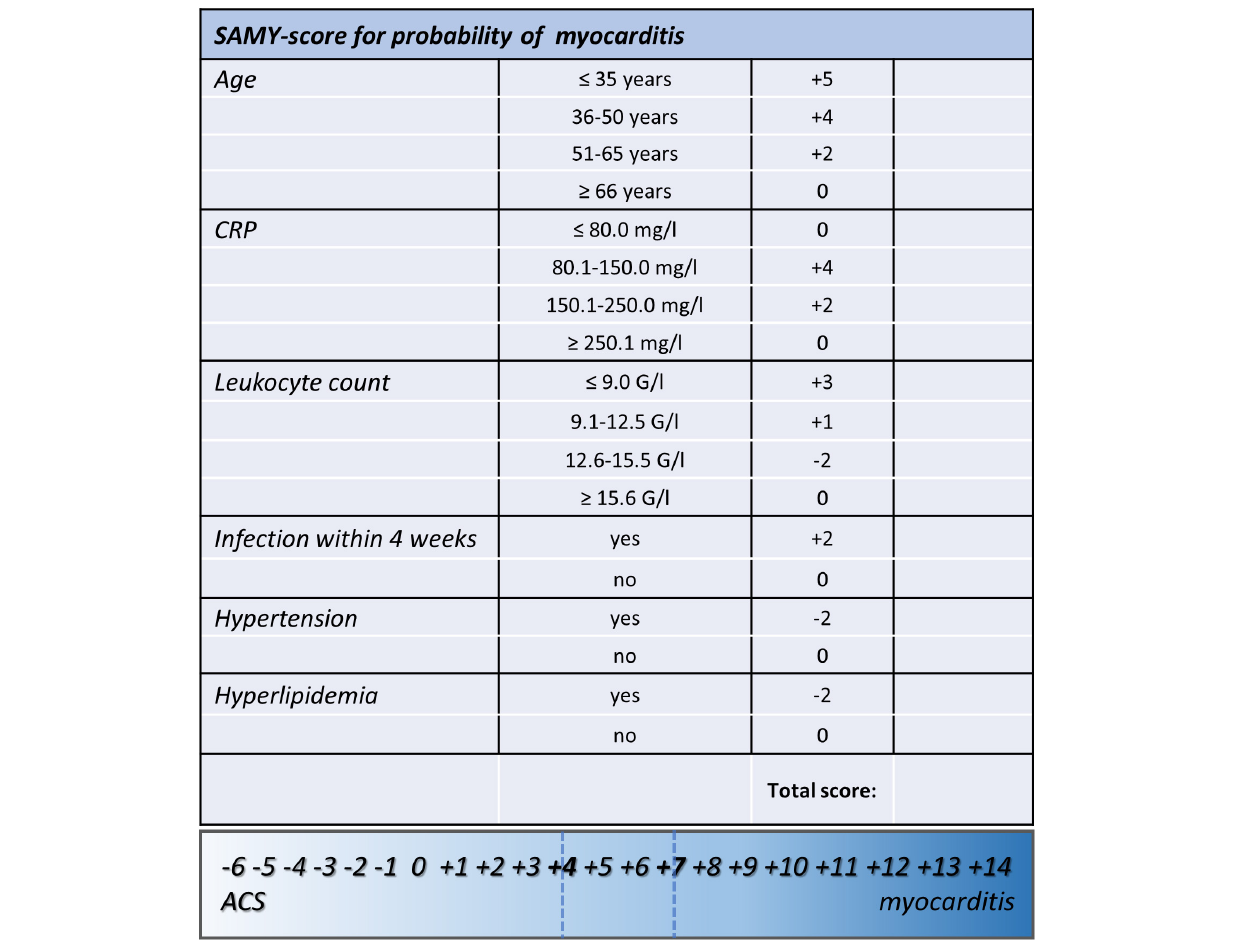
Frontiers in Medicine |